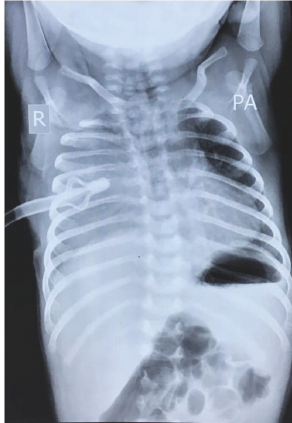
Figure 1: Chest radiograph showing a homogeneous opacity in the right middle and lower lung fields with shift of mediastinum to left.